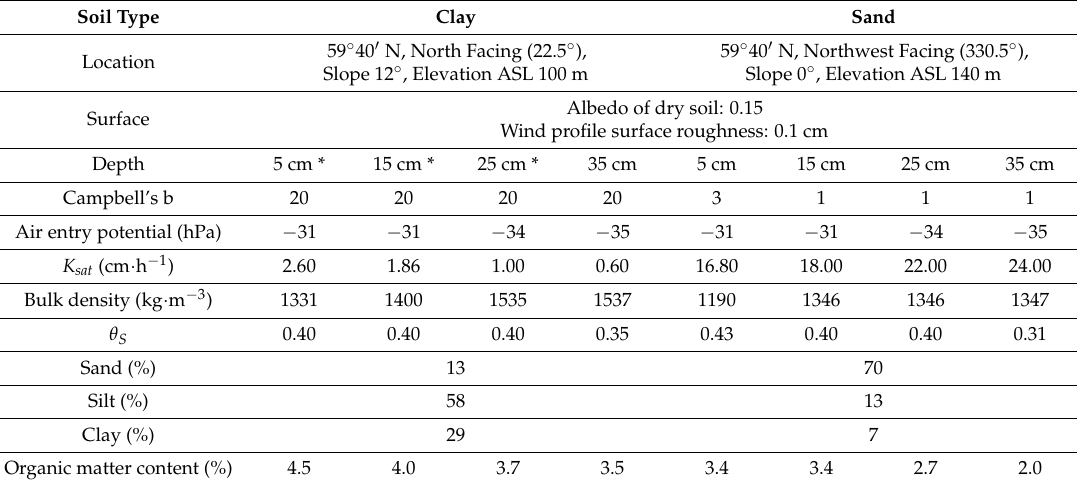
Table 1. Input parameters for the SHAW model. Only the three layers marked with an asterisk (*) were used for the 2013 simulation, and the depth was reduced from 15 down to 10 cm and from 25 cm down to 20